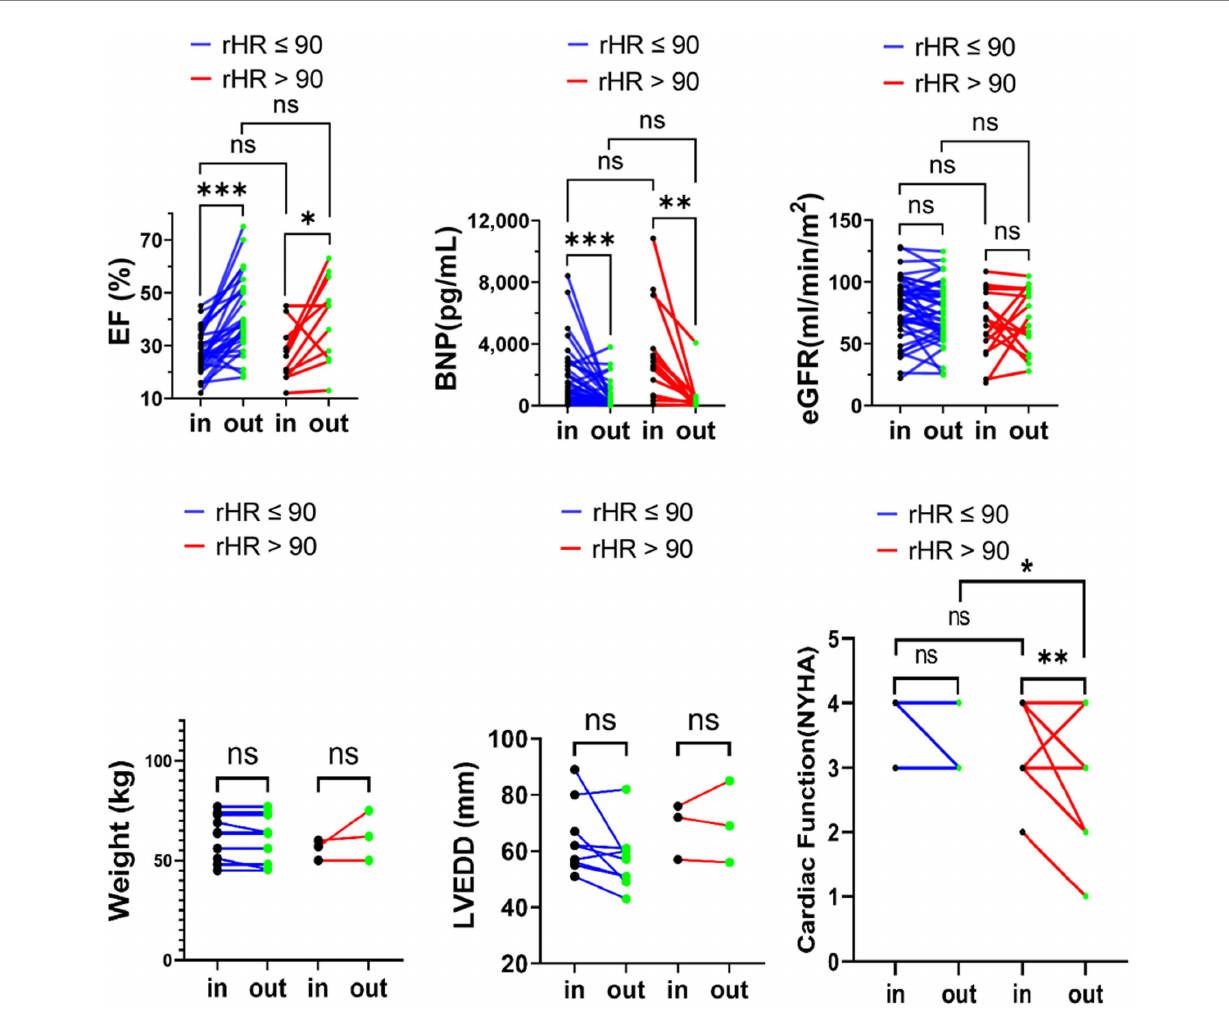
FIGURE 4 eGFR, LVEF, and BNP body weight, LVEDD, NYHA classification variation upon admission and at discharge in advanced HFrEF patients with rHR ≤ 90 bpm or rHR > 90 bpm. * p < 0.05; ** p < 0.01; *** p <